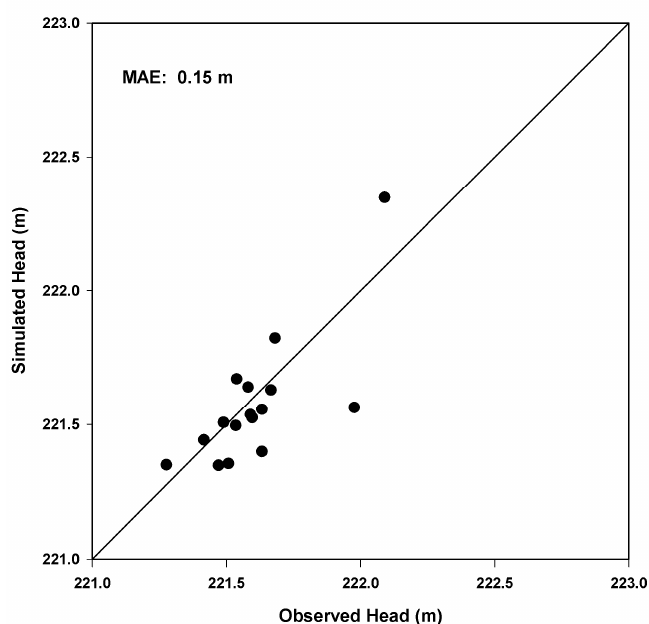
Figure 4. Measured head (groundwater head values observed in the field) versus simulated head (modeled head values at each measuring location). The residuals analysis results in a mean absolute error (MAE) of 0.15 m. Black line shows the 1:1 ratio for an ideal model solution.